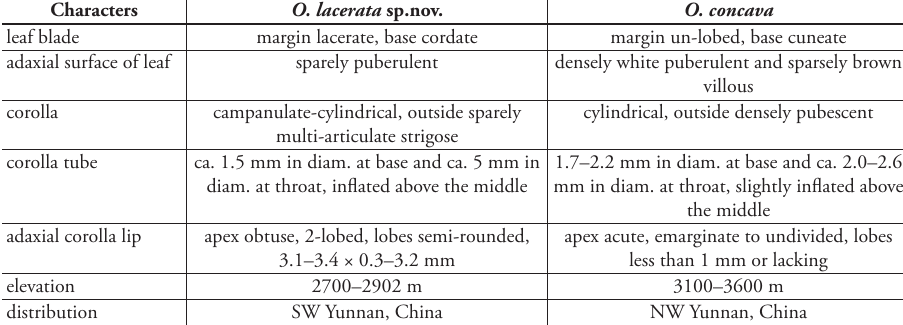
Table 3. Differences between Oreocharis lacerata and O. concava in Gesneriaceae. Characters O. lacerata